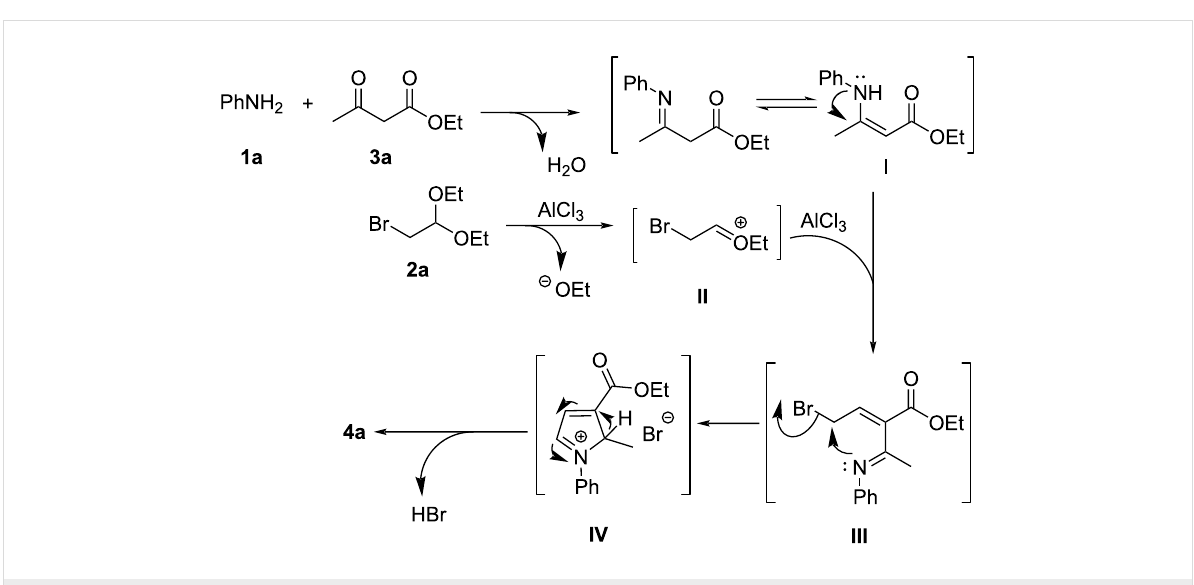
Scheme 5: Plausible mechanism of the three-component